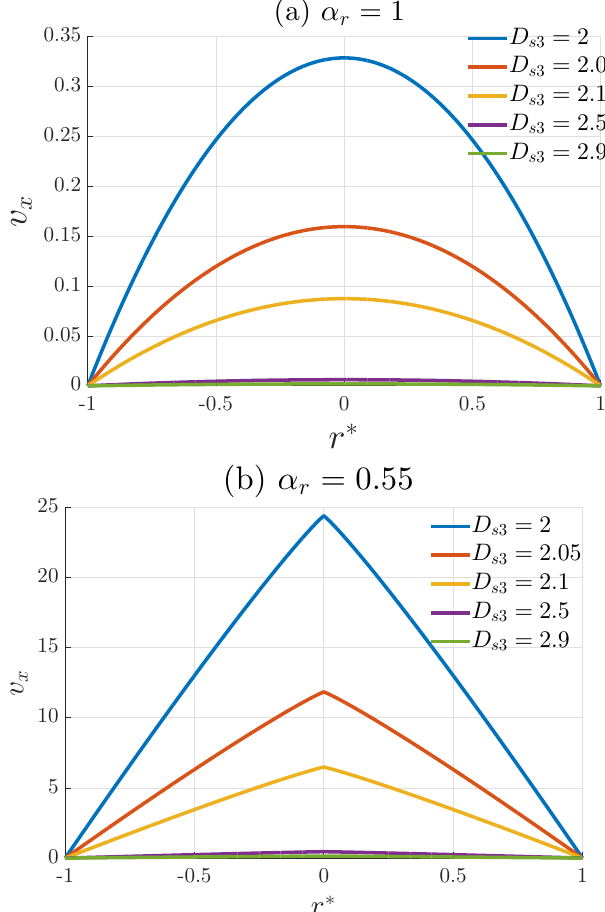
Figure 6. Plots of velocity profiles defined by Equation (28), with r ∗ = r / r e , d x = 0.9, ∆ p = 25 Pa, µ = 10 − 3 Pa.s, and c = 100 m 1 − γ .